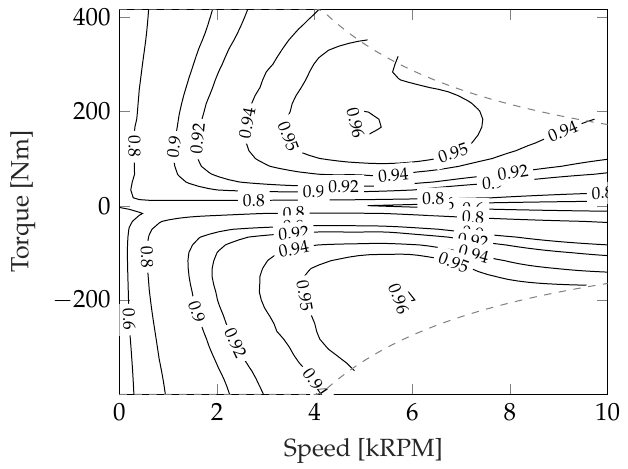
Figure 4. Efficiency map of the traction machine including inverter. The dashed line shows the constant power limit.